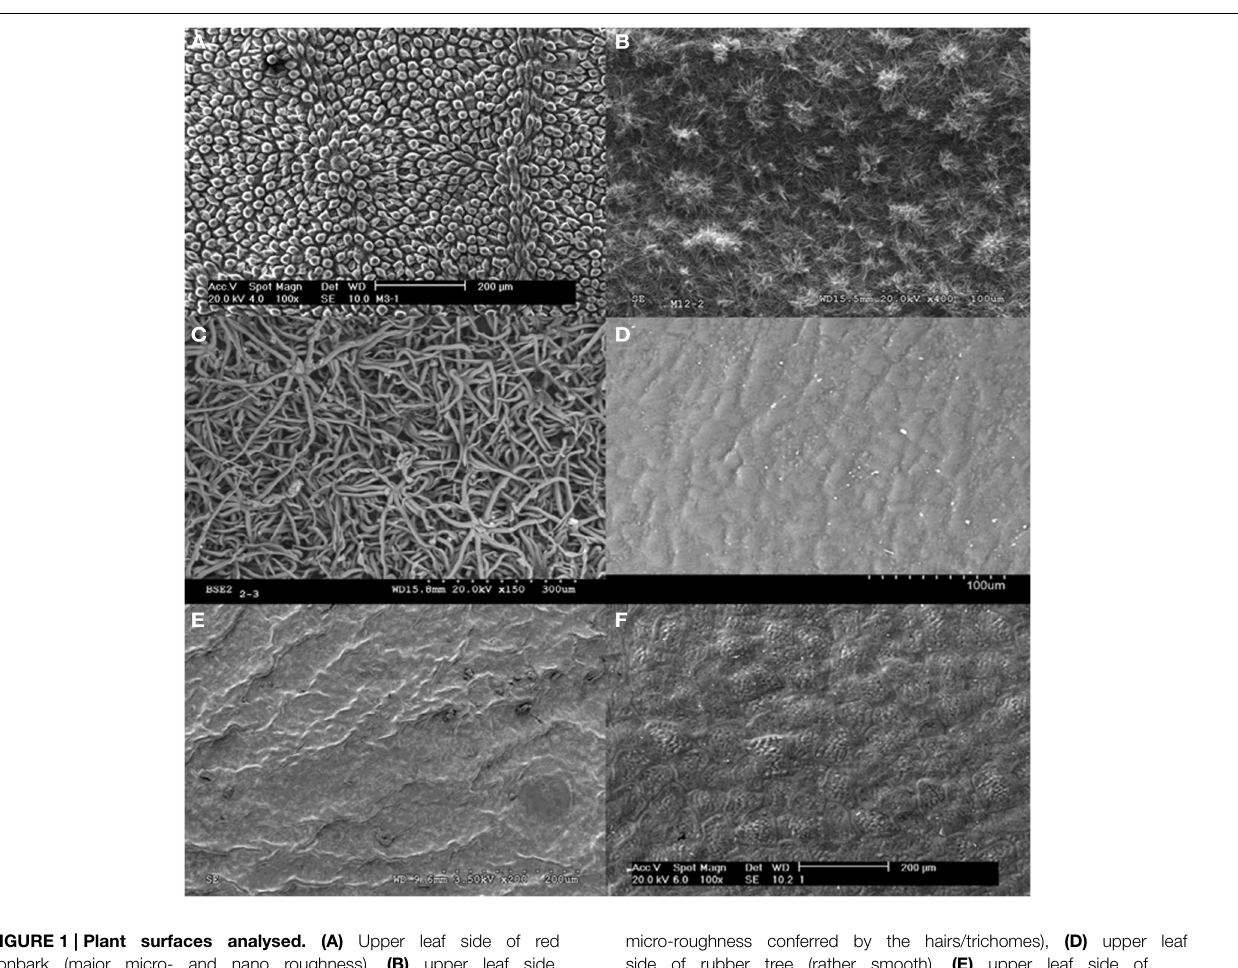
micro-roughness conferred by the hairs/trichomes), (D) upper leaf side of rubber tree (rather smooth), (E) upper leaf side of Chilean myrtle (rather smooth), and (F) pepper fruit surface (rather smooth).